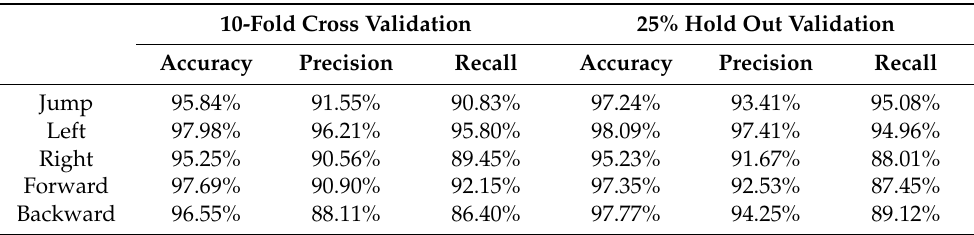
Table 4. Evaluation of Decision tree